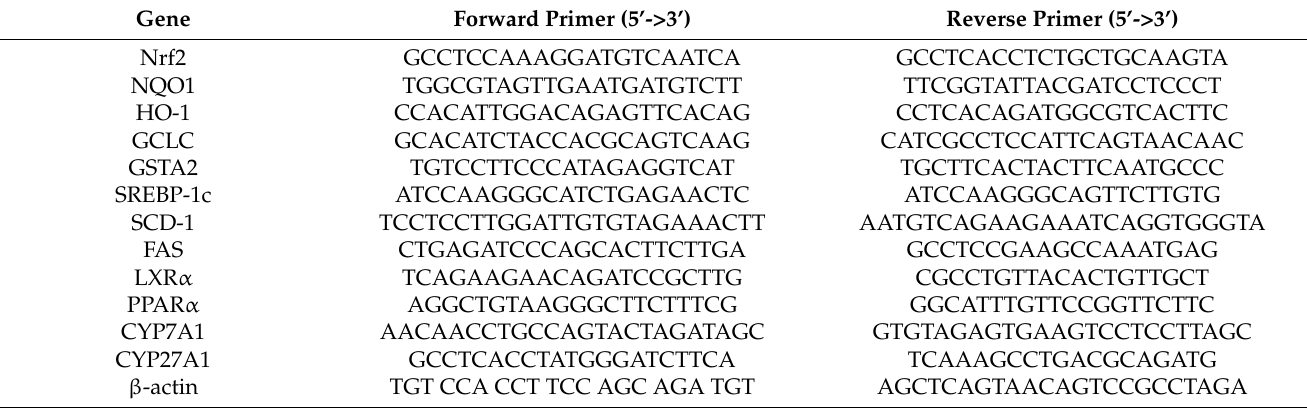
Table 2. Primer sequences used for